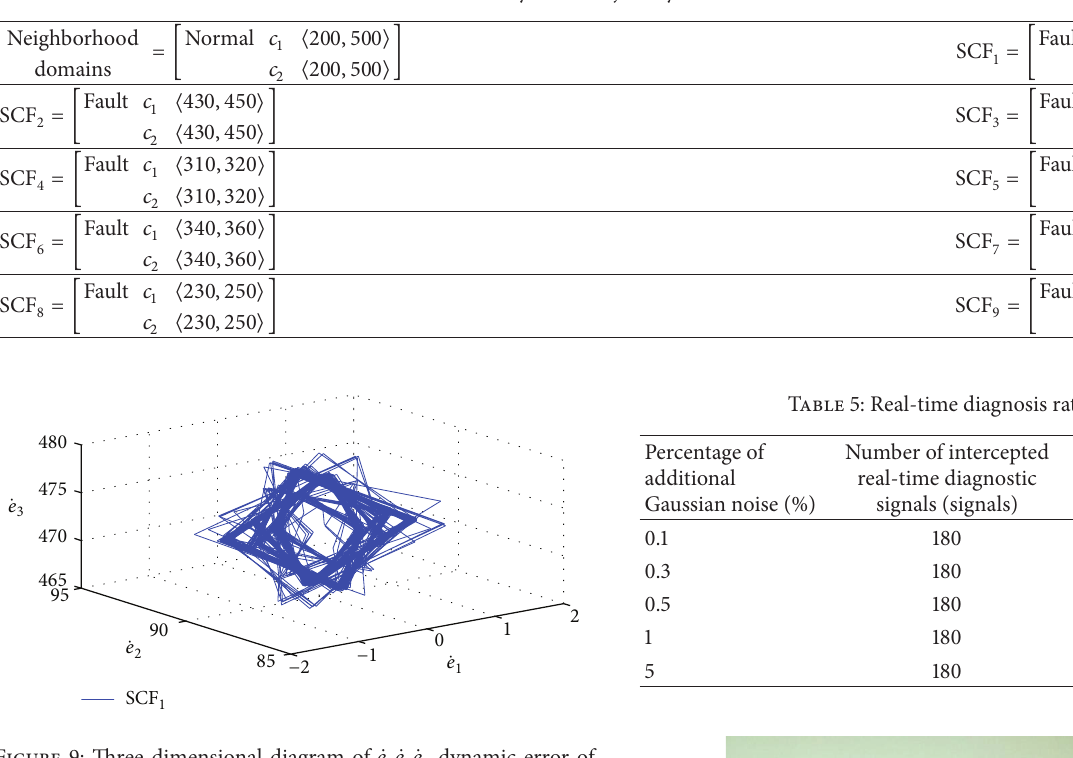
Figure 9: Three-dimensional diagram of ̇𝑒 1 ̇𝑒 2 ̇𝑒 3 dynamic error of SCF 1.